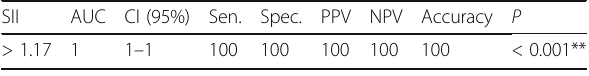
Table 4 Validity of SII in differentiating physiological from pathological radioactivity at a cutoff value 1.17